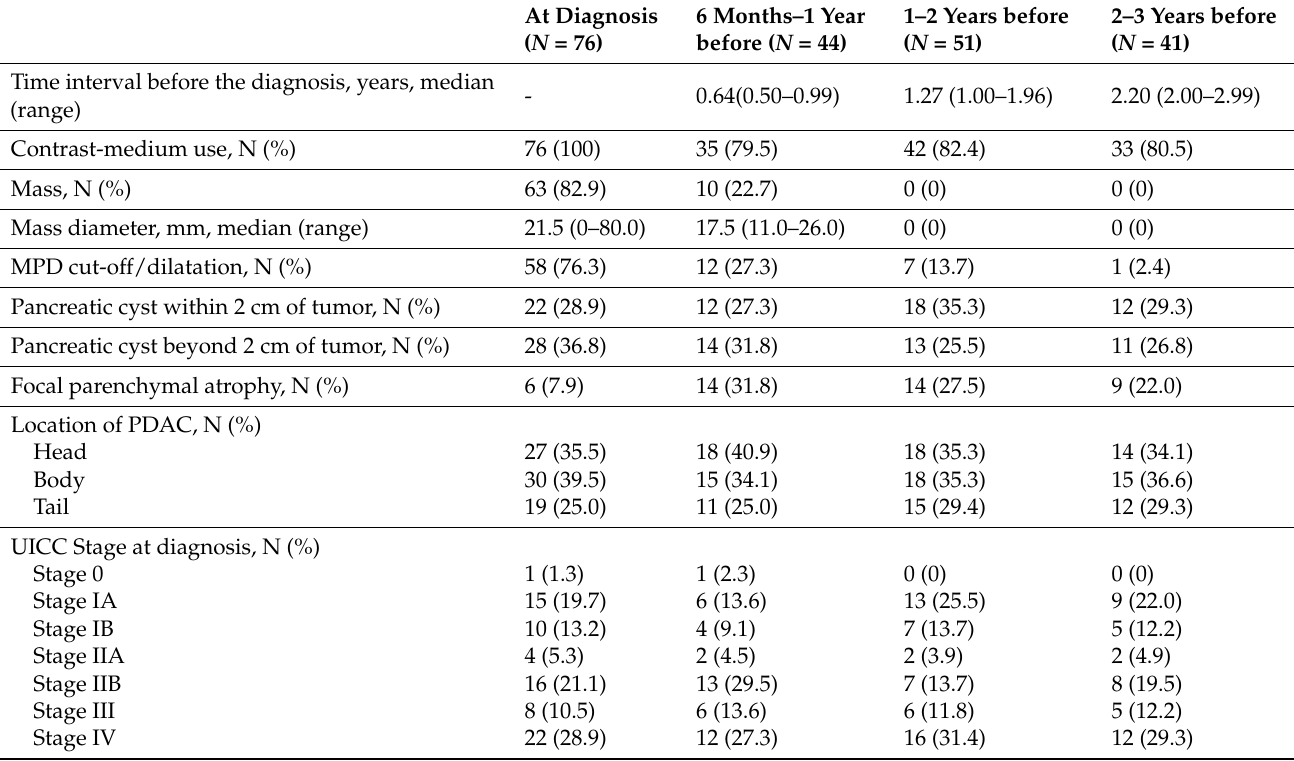
Table 2. CT findings by time interval before the diagnosis of